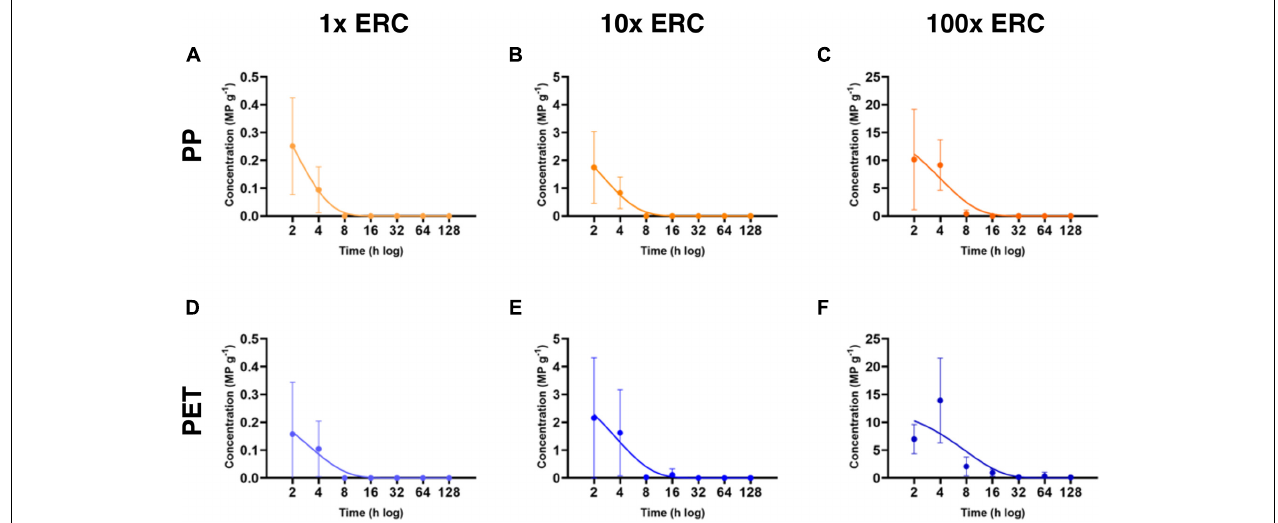
FIGURE 3 | Mean microplastic body burden fish − 1 ( ± standard deviation) in three treatment groups ( n = 84 tanks) during a single exposure of adult damselfish Pomacentrus amboinensis to polypropylene (PP) particles and polyethylene (PET) fibers in a controlled laboratory experiment. Mean body burden is presented for four damselfish collected at each of the seven depuration times (2, 4, 8, 16, 32, 64, and 128 h). ERC, environmentally relevant concentrations. Each graph corresponds to a combination of experimental microplastic and concentration of exposure. (A) PP-ERC, (B) PP-10x ERC, (C) PP-100x ERC, (D) PET-ERC, (E) PET-10x ERC, and (F) PET-100x ERC.